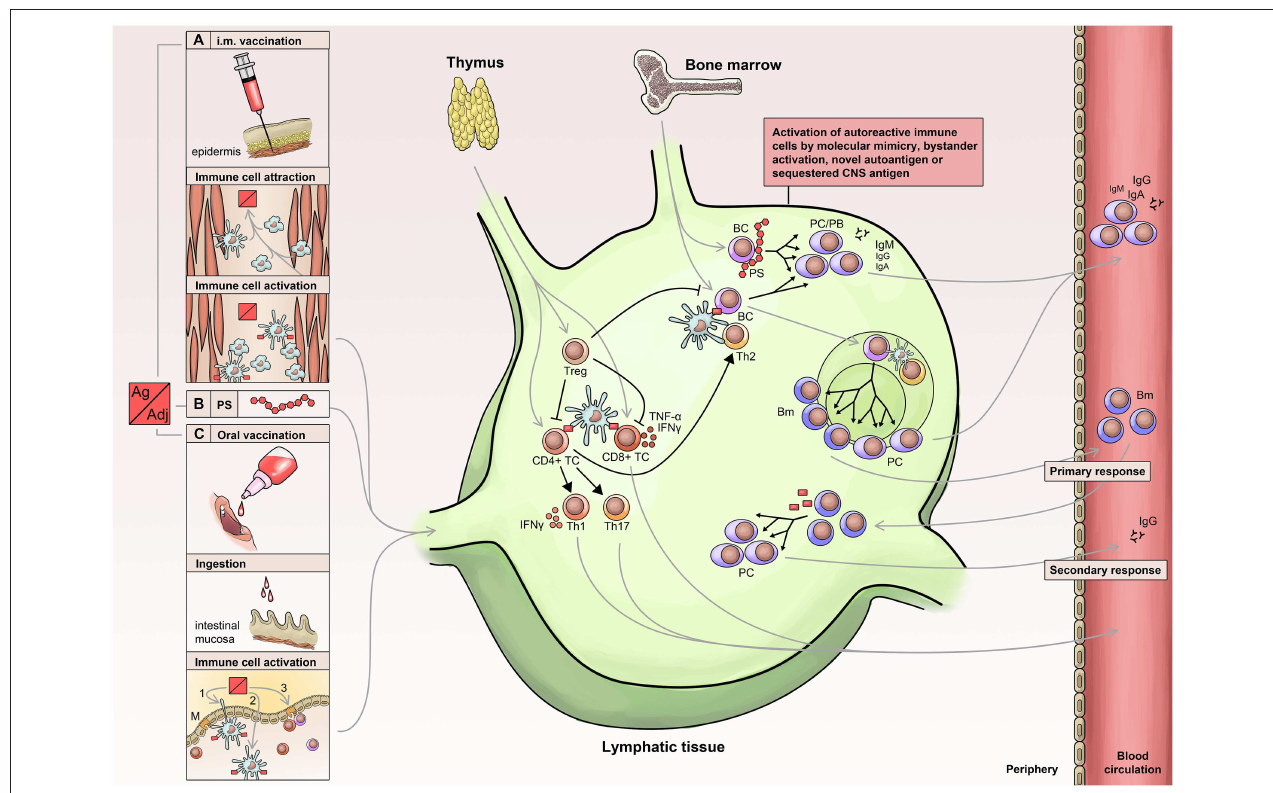
FIGURE 1 | Immunology of vaccination. Routes of vaccine administration include: Injection of vaccine into muscle tissue (A) leading to attraction, activation, uptake and processing (B) in APCs (antigen-presenting cells), which then migrate to lymphatic tissue. Similarly, oral or nasal administration (C) leads to activation and migration of innate immune cells into the lymphatic tissue. APCs activate lymphocytes leading to a T cell immune response and activation of B cells, which receive additional stimuli by activated T helper cells. The primary immune response is short-lived and associated with the early appearance of low affinity antibodies, which are later replaced by high affinity antibodies generated via the germinal center reaction. PS, polysaccharide; PC, Plasma cell; PB, plasma blast; BC, B-cell; Bm, memory B cells; Treg, Regulatory T